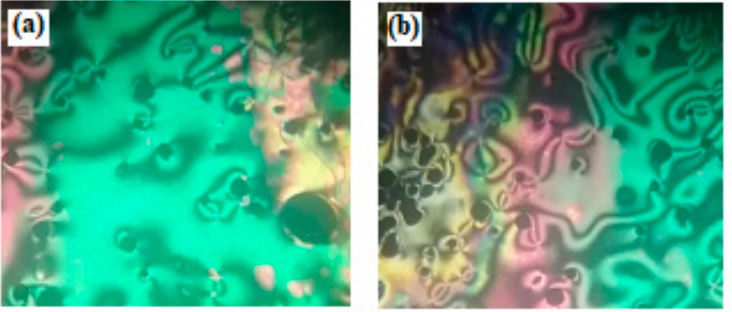
Figure 4. Nematic phase textures under polarized-optical microscopy (POM) of the supramolecular complexes ( a ) A 10 / I 8 at 72.0 °C upon heating; and ( b ) A 12 / II 16 at 77.0 °C upon cooling.